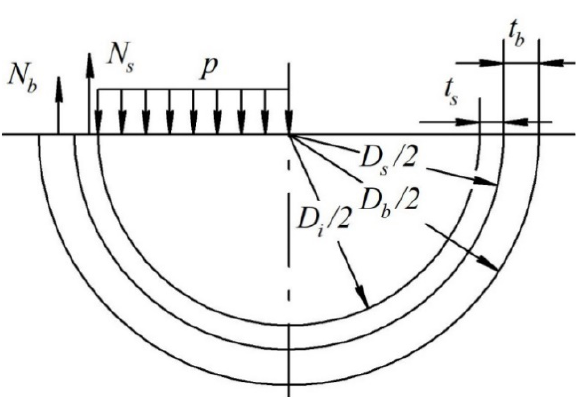
Fig. 1. Equal balance of a half-ring cut from a pipe under the internal pressure (to increase the bearing capacity of the pipe- line).